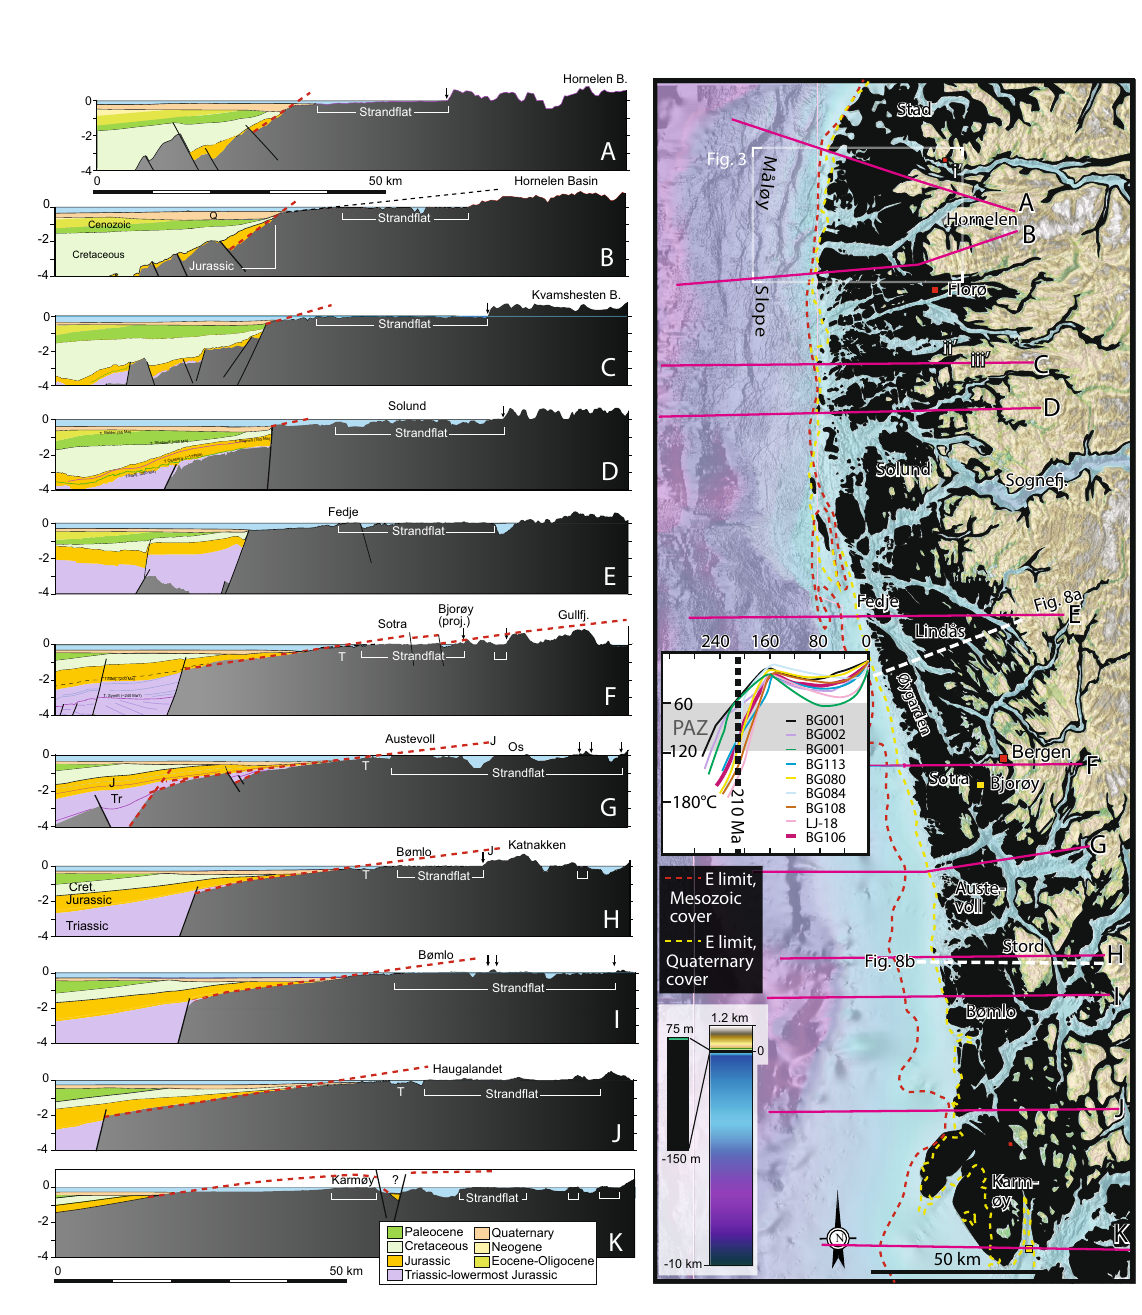
Fig. 5 Pro fi les constructed across the on-offshore study area. Pro fi les A-K (left panel) are based on topographic, bathymetric, and 3D seismic data. Dark gray is crystalline basement (including mildly metamorphosed Devonian sedimentary rocks). The sections are constructed approximately perpendicular to the trend of the strand fl at. The main portion of the strand fl at is annotated on the pro fi les, and the strand fl at as well as near-sea level shoulders in the fjords are marked in black on the map (right panel). White dashed lines on the right panel are locations of pro fi les shown in Fig. 8. Inset graph in right panel shows time-temperature models (weighted mean paths) from apatite fi ssion track and (U – Th)/He data from the strand fl at near Bergen (mostly Øygarden-Sotra area), extracted from Ksienzyk et al. (2014). 210 Ma, the time of previously proposed weathering, is highlighted. PAZ; Partial Annealing